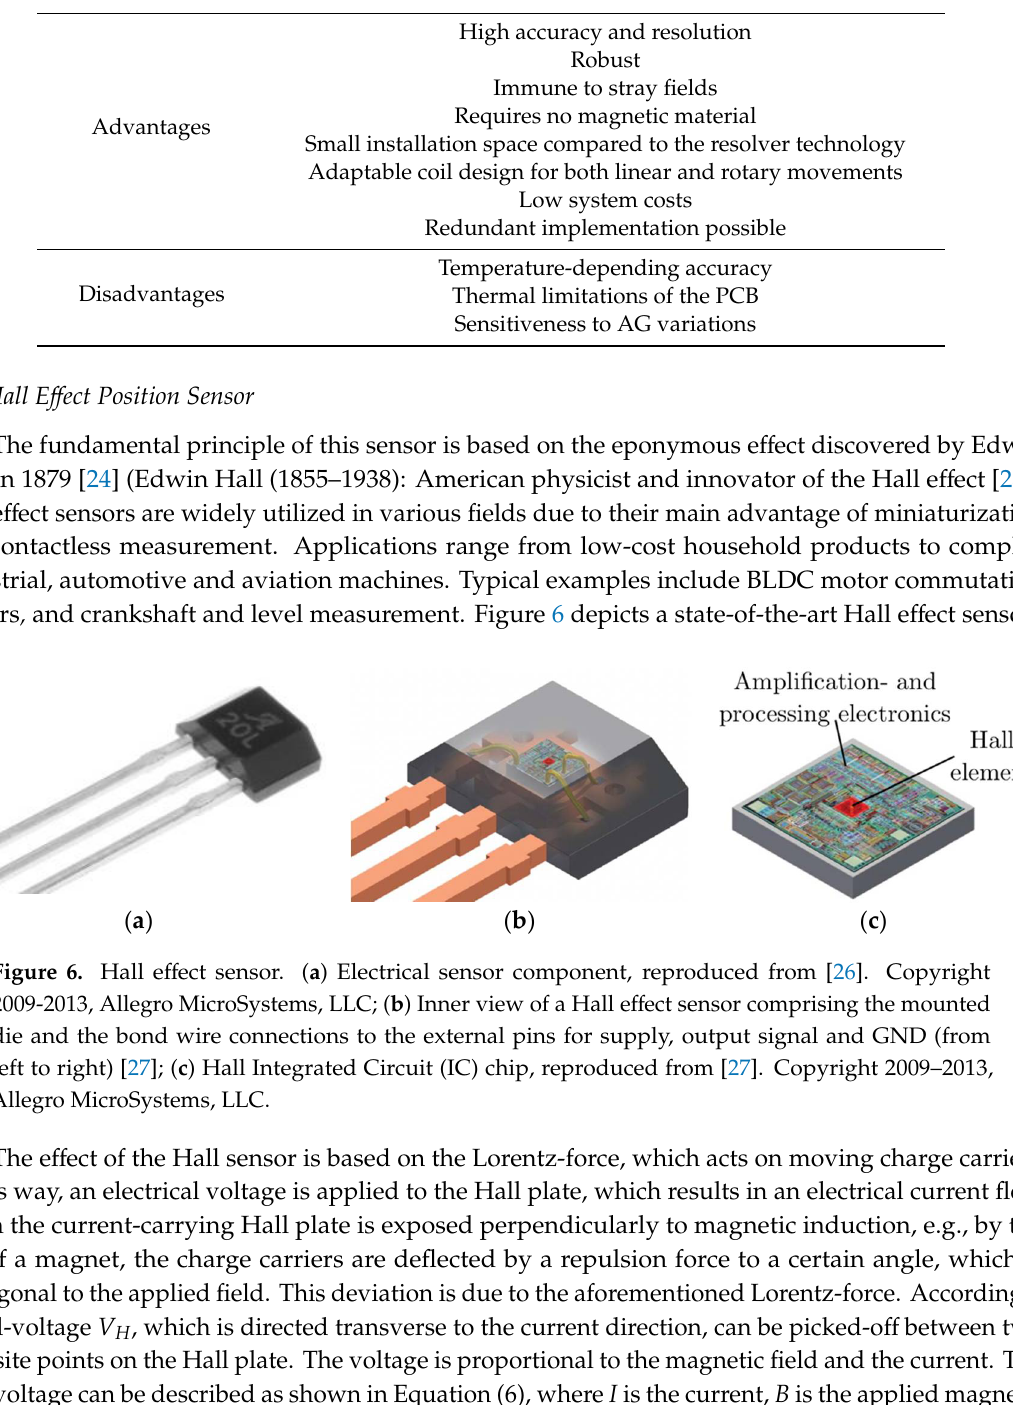
Figure 7. Illustration of the Hall effect principle, reproduced from [9]. Copyright 2007, Robert Bosch GmbH. There are two main types of Hall effect sensors: linear devices and threshold types. Linear Hall sensors provide a proportional analog output voltage according to the magnetic field strength of the applied magnet. The output voltage moves into the supply direction (e.g., at a south pole) or GND (e.g., in case of a north pole). This can be achieved by a differential Operational Amplifier (OPAMP). As a result, the output voltage is dependent on the orientation of the magnet. When no magnet is detected at all, a bias voltage is present, which is also described as a Null voltage. Note that the fixed offset introduced is to avoid putting two power supplies in the processing circuit, which reduces the overall system costs [28]. A linear Hall sensor can be found, for example, in automotive throttle pedals.